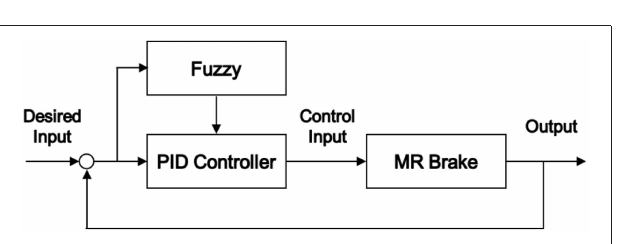
FIGURE 8 | Comparison of the measured workspaces. (A) Pitch motion. (B) Yaw motion.